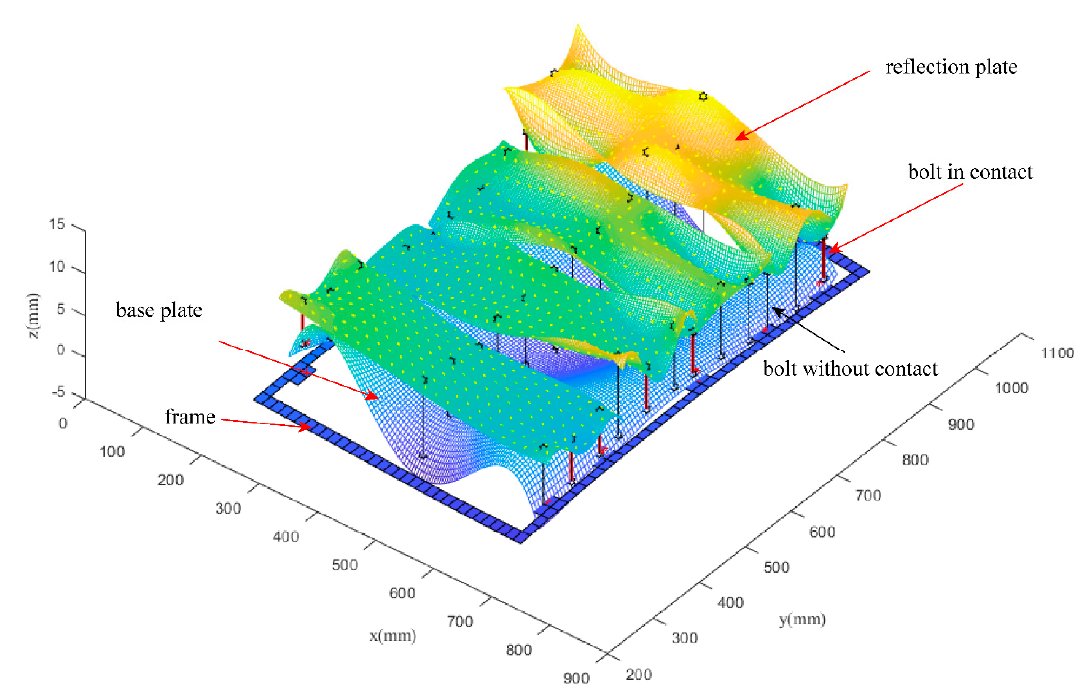
Figure 8. The final state of the whole array from a set of the samples.